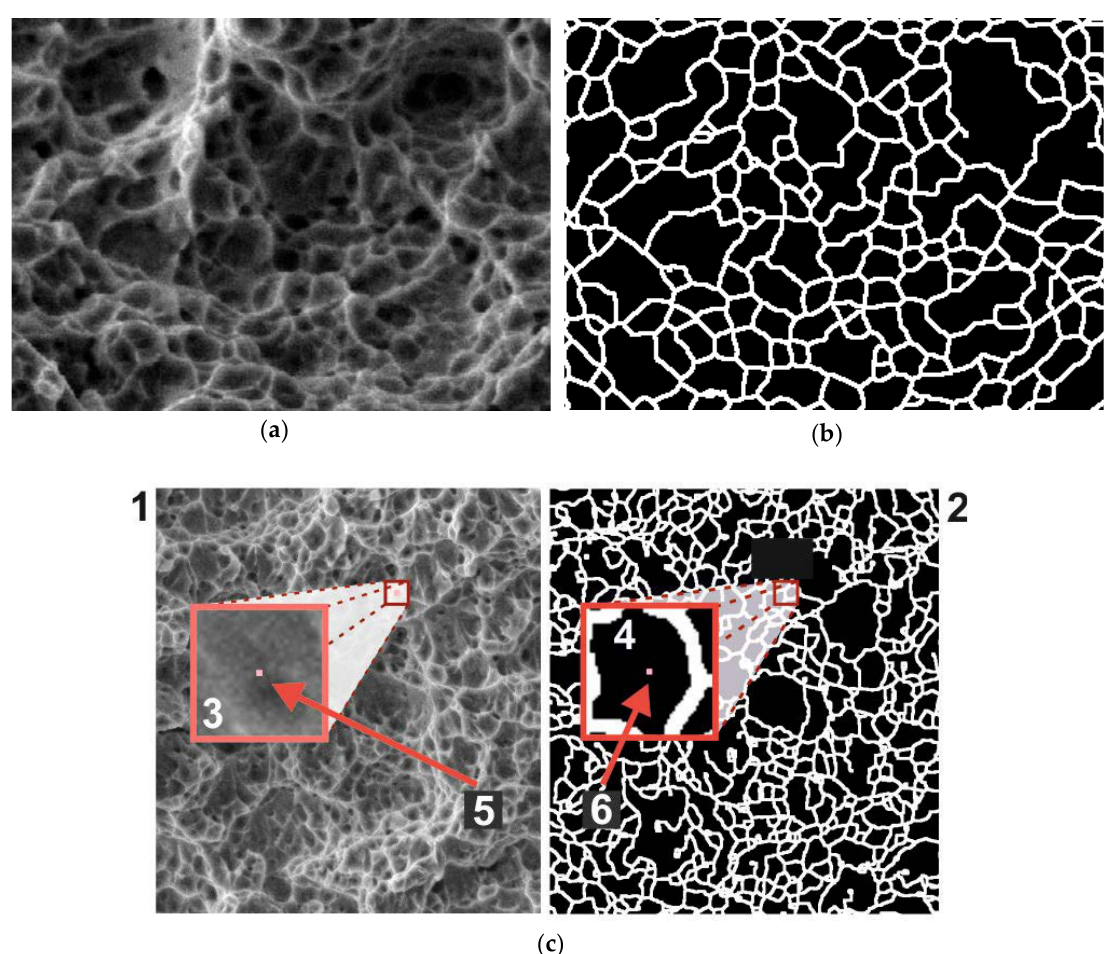
Figure 1. ( a ) Dimples of viscous detachment on the surface of a specimen from titanium alloy VT23; ( b ) the result of their detection using the algorithm [22]; ( c ) a diagram illustrating the principle of training the neural network: (1) training image, (2) image with correct answer labels, (3) zoomed fragment of training image with the size 2w k + 1 × 2w k + 1, which is an element of the training set, (4) fragment of the image with labels, which by its position and size corresponds to (3), (5) the central pixel of (3), and (6) the pixel containing the correct answer label for (3).